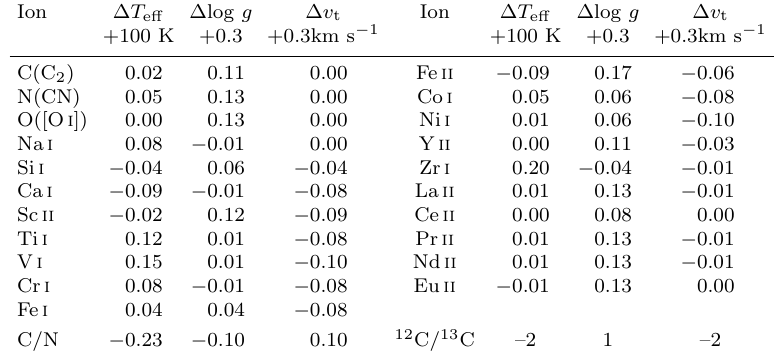
Table 2. Sensitivity of the abundances to changes of the atmospheric parameters. The table entries show the effects on the logarithmic abundance relative to hydrogen, ∆ [El/H].